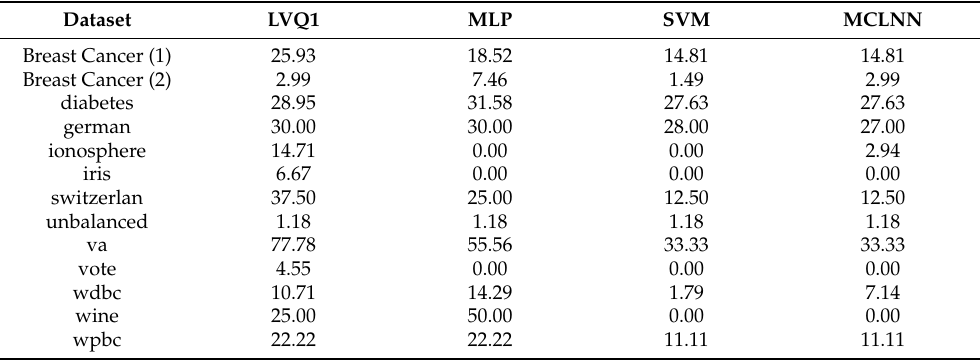
Table 8. Comparison of the best error rates given by different techniques and the proposed neural architecture applied to the testing dataset (exploitation